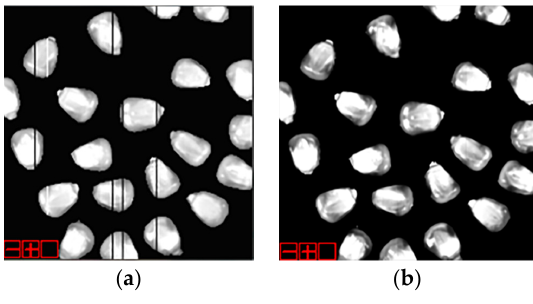
Figure 4. Images at ( a ) 1111 and ( b ) 1240 nm.